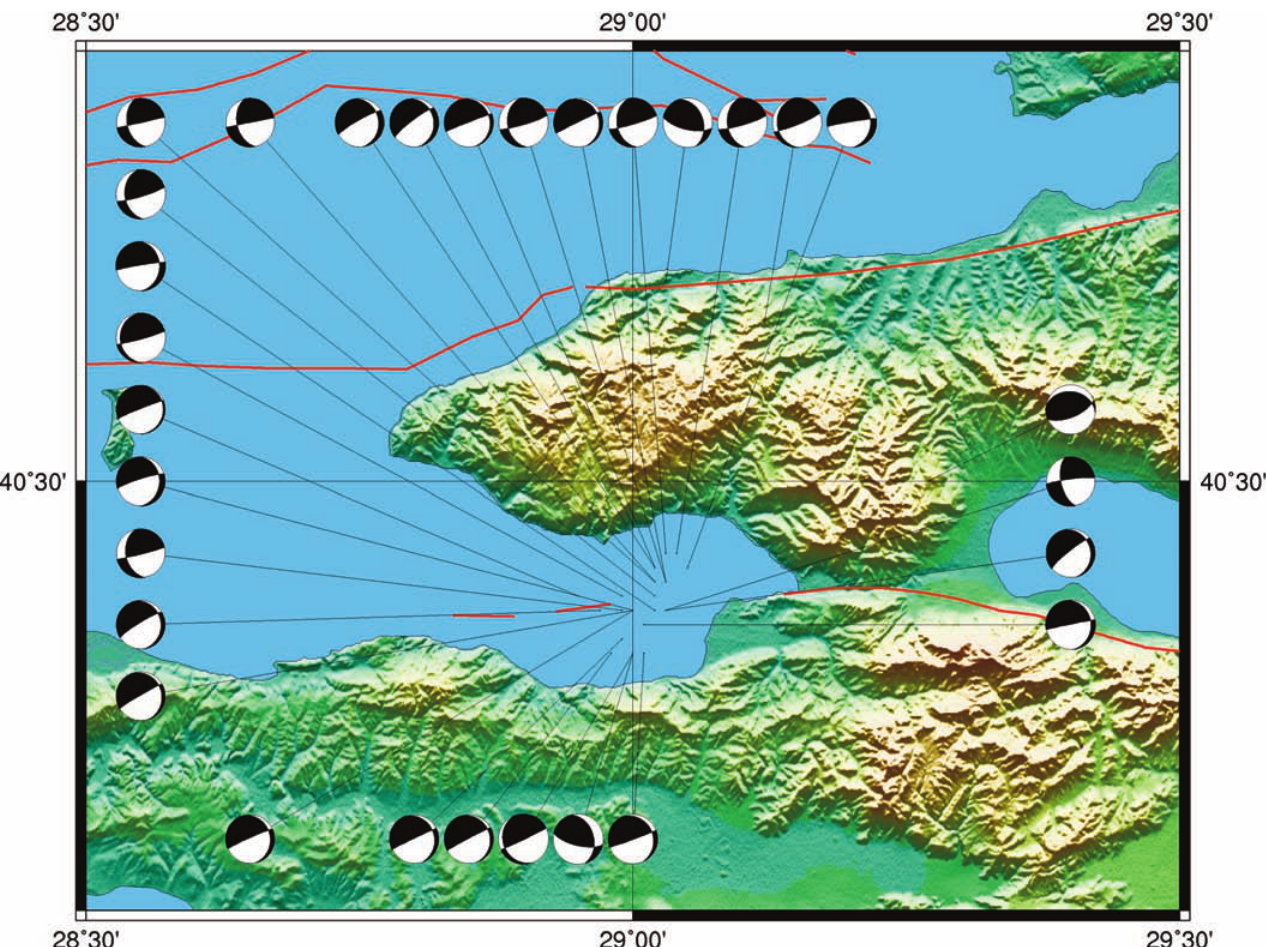
Figure 11. Focal mechanisms of some of the